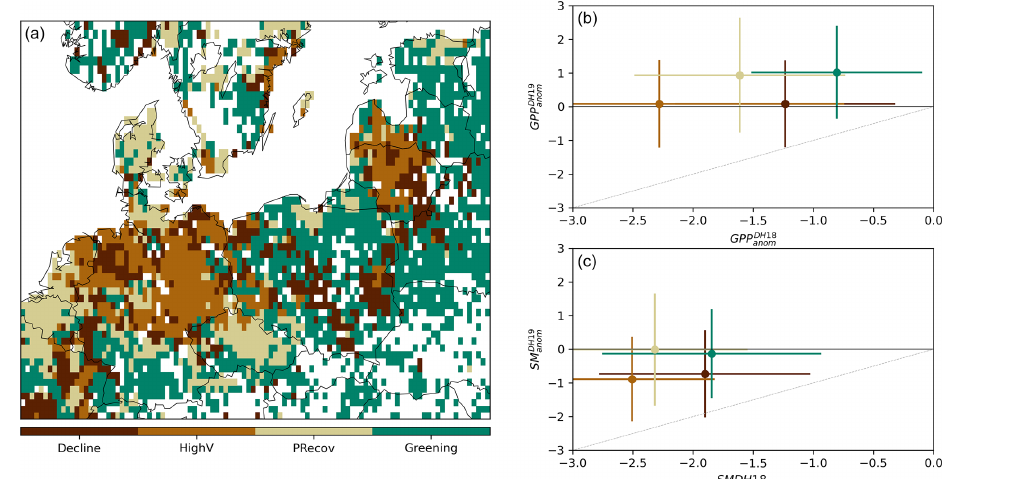
Figure B7. Panel (a) shows the spatial distribution of the four clusters from unsupervised classification of (EVI DH18 anom , EVI DH19 anom ) values remapped to the coarser grid of LSMs. The corresponding (GPP DH18 anom , GPP DH19 anom ) values simulated by the multi-model mean in each clus- ter are indicated in (b) (circles indicate the spatial mean and the lines spatial standard deviation within each cluster). The corresponding distribution of simulated SM anom pairs in each cluster are shown in (c) . The grey line indicates similar anomalies in the two DH events.